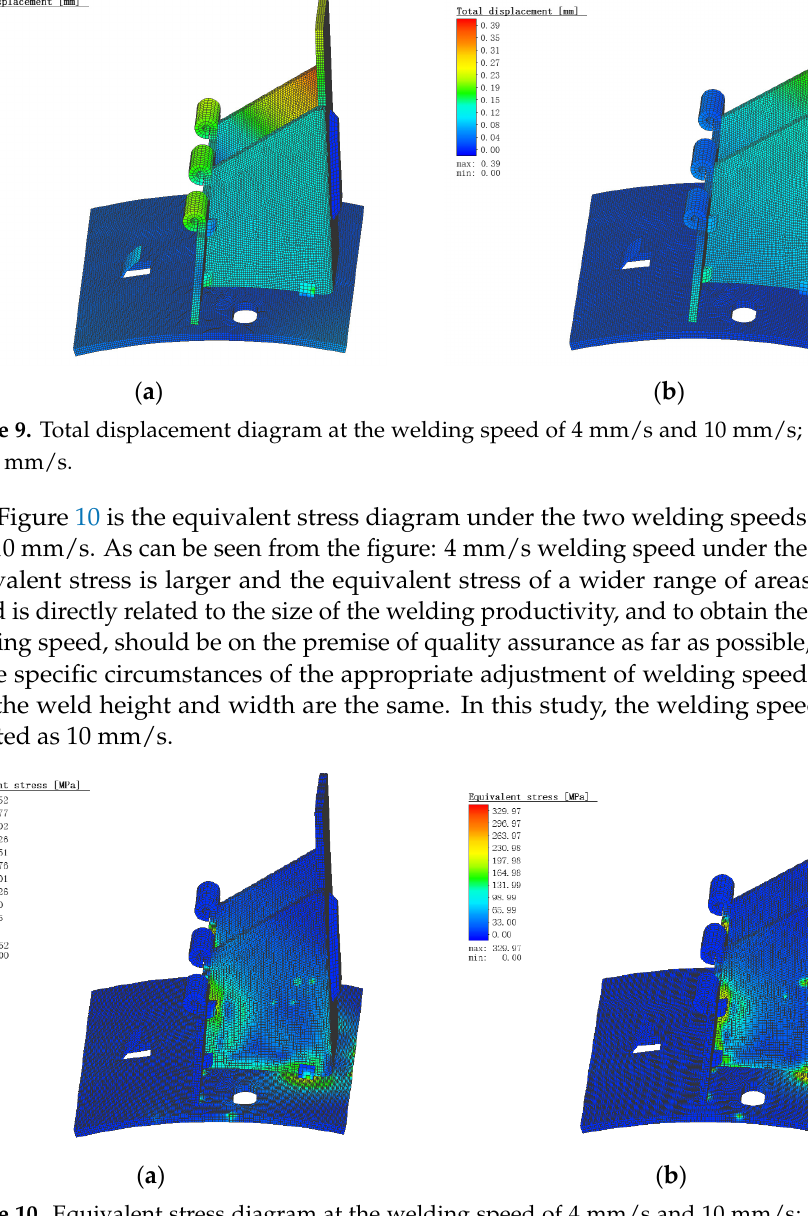
( b ) Figure 8. Equivalent stress diagram under continuous welding and spot welding. ( a ) Continuous welding; ( b ) spot welding. 3.3.3. Effect of Welding Process Parameters on Welding Deformation and Stress Figure 9 is the total displacement diagram of the duckbill welded parts when the welding speed is 4 mm/s and 10 mm/s. It can be seen from the figure that the total dis- placement difference between the two welding speeds is 0.13 mm, but at the welding